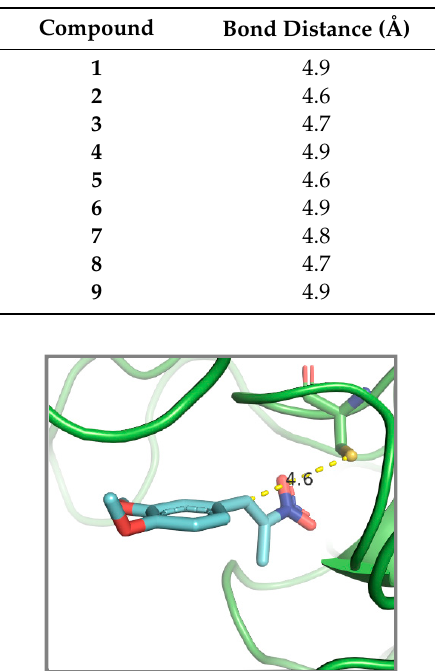
Figure 7. Bond distance between β -carbon of compound 2 and thiol of Cys215, simulated using PyMol 2.0. The colors represent the element or atom (Red: Oxygen; Blue: Nitrogen; Yellow: Sulphur; Orange: Phosphor; Green: Carbon of the receptor residues; Cyan: Carbon of ligand; Dotted Yellow line: Interaction between the atoms).